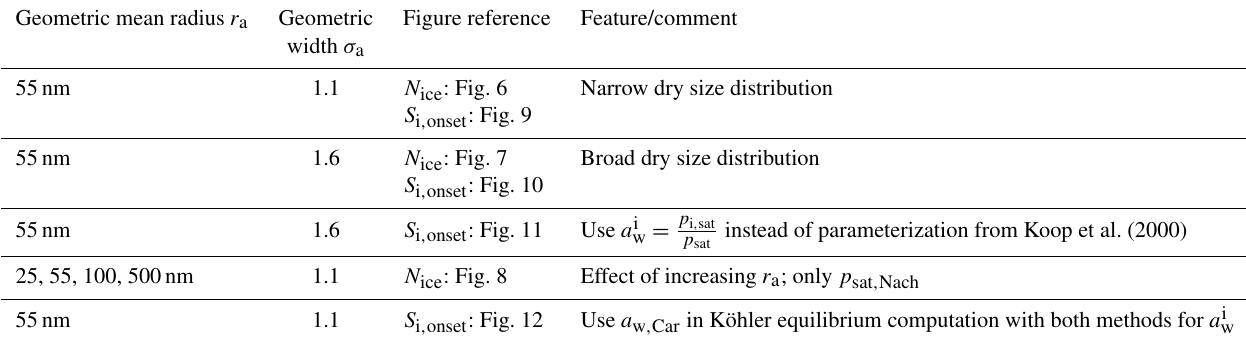
Table 2. Summary of the various simulation setups discussed in this study; N ice refers to a plot of the number of nucleated ice crystals versus the updraft velocity and S i , onset to a plot of the freezing ice saturation ratio versus